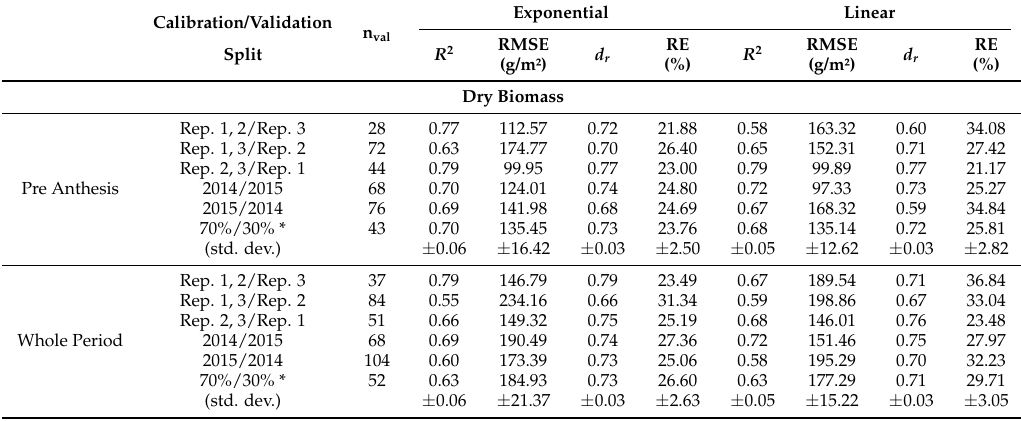
Table 4. Regression of observed versus predicted biomass. For the repeated 70%/30% split, standard deviations of all characteristic parameters are reported. n val : number of samples in validation dataset; R 2 : coefficient of determination; RMSE: root mean square error; d r : Willmott’s refined index of model performance; RE: mean relative